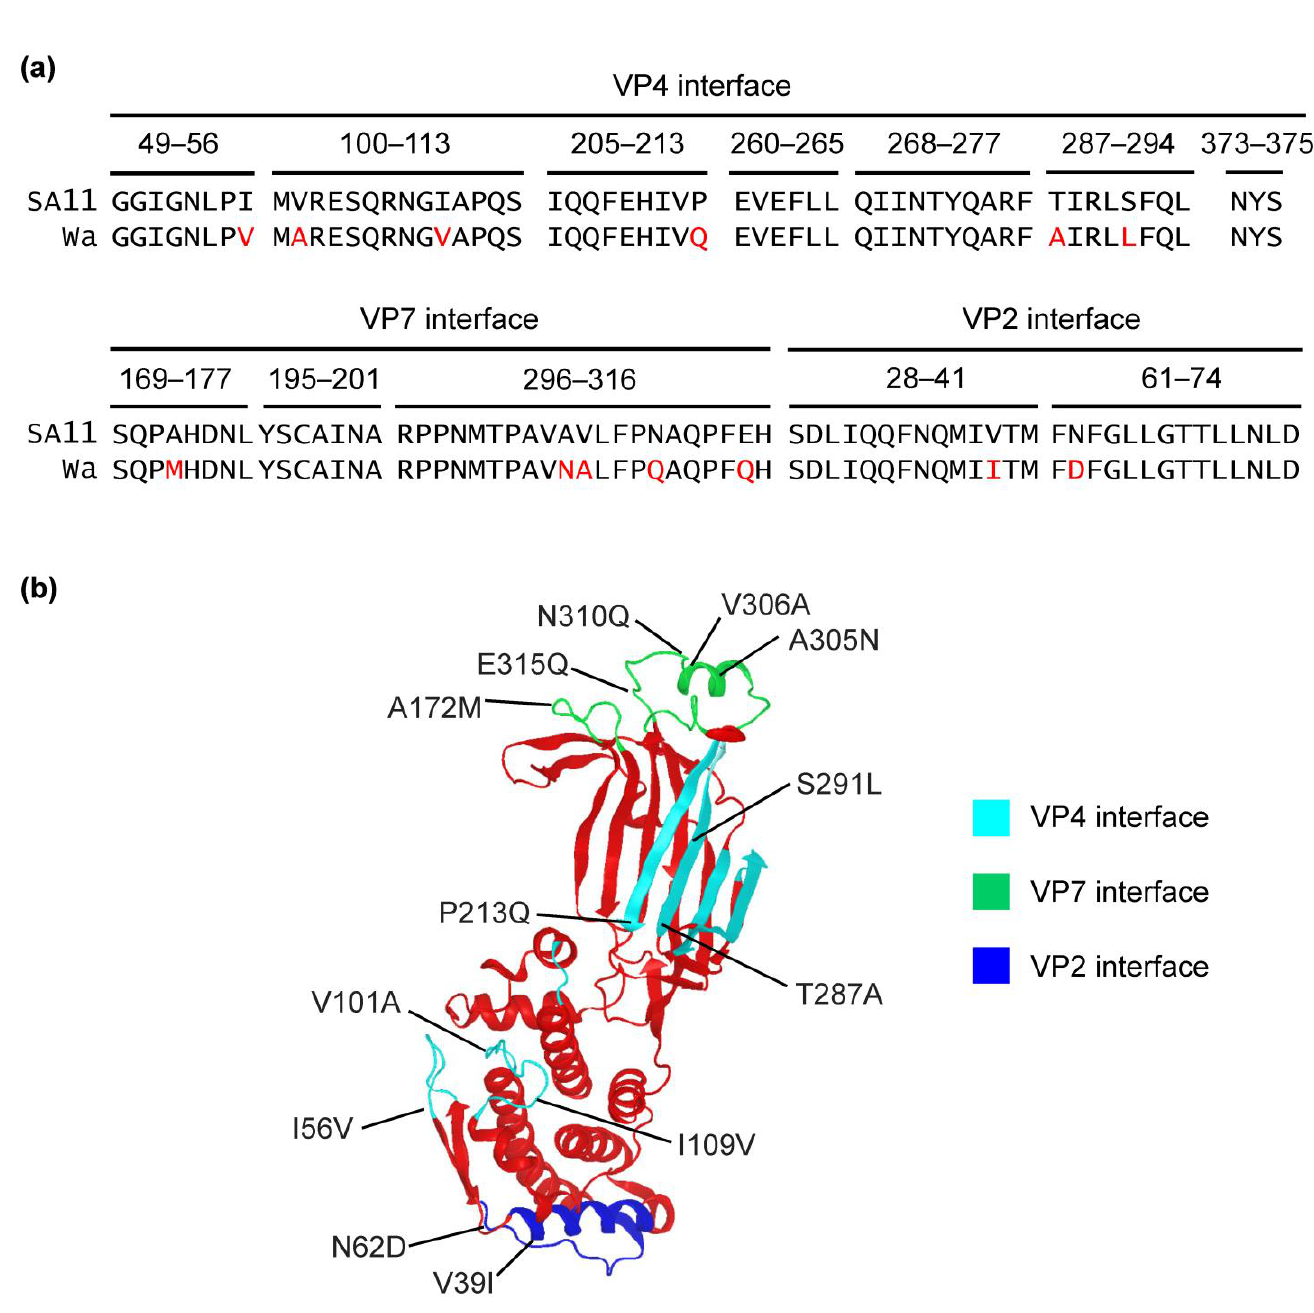
Figure 5. VP4, VP7, and VP2 protein interfaces of VP6. ( a ) Alignment of the amino acid residues located in the interaction sites of VP6 with VP4, VP7, and VP2. The numbers refer to the positions of the amino acid residues that are interfacing with the indicated viral protein. Differences between SA11 and Wa are highlighted in red. ( b ) Location of the identified differences between SA11 and Wa in the atomic structure of VP6 from rhesus rotavirus [5].